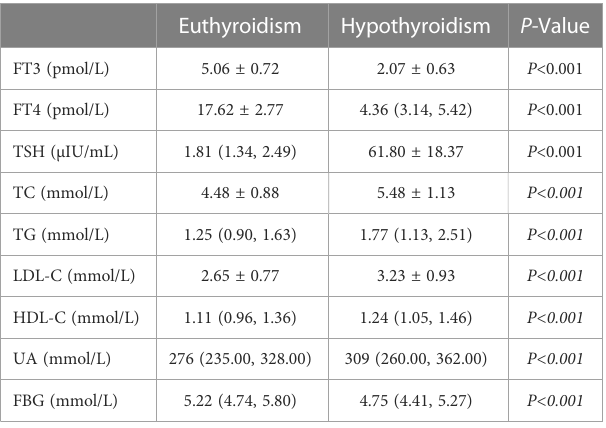
TABLE 2 Parameters in different thyroid states.